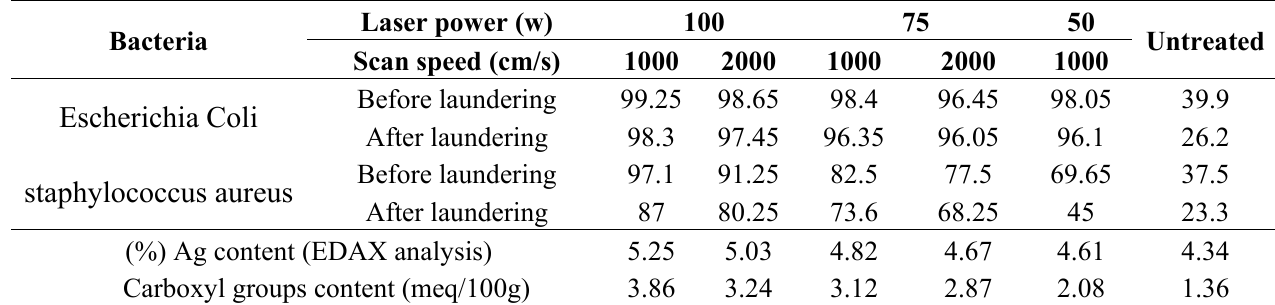
(%) Ag content (EDAX